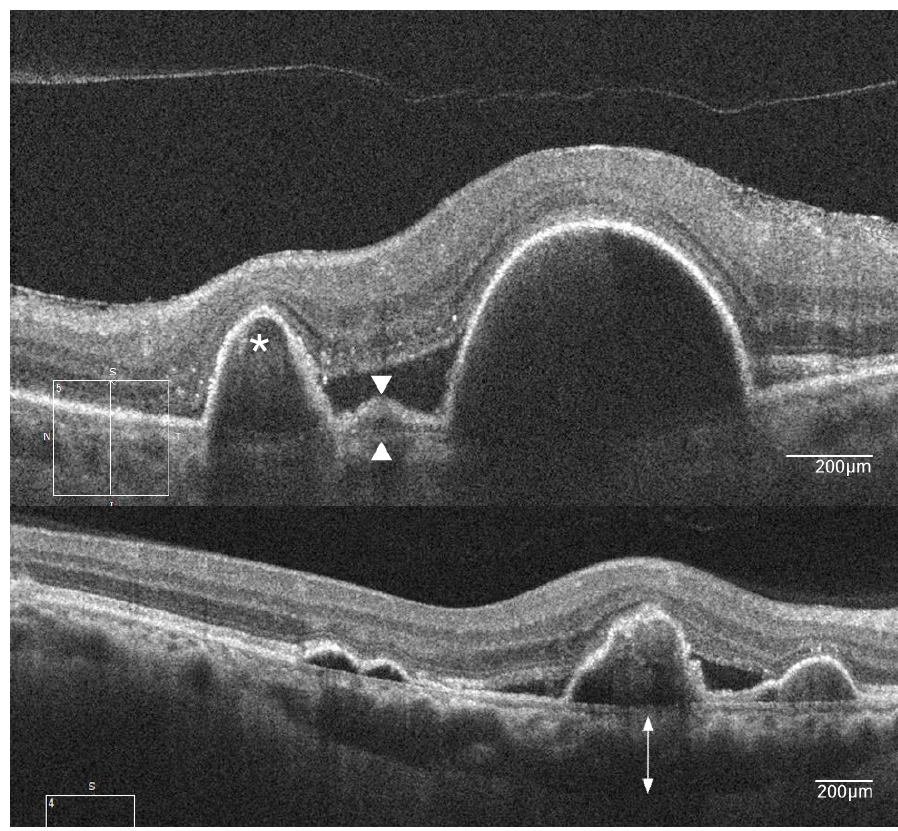
Figure 3. Spectral domain optical coherence tomography (OCT) features of PCV. The image on the top shows a sharp elevation of the retinal pigment epithelium (RPE) with underlying moderate reflectivity (asterisk) and double-layer sign, consisting of two hyper-reflective lines (white arrowheads). The bottom image shows the underlying thickened choroid (double-headed arrow).